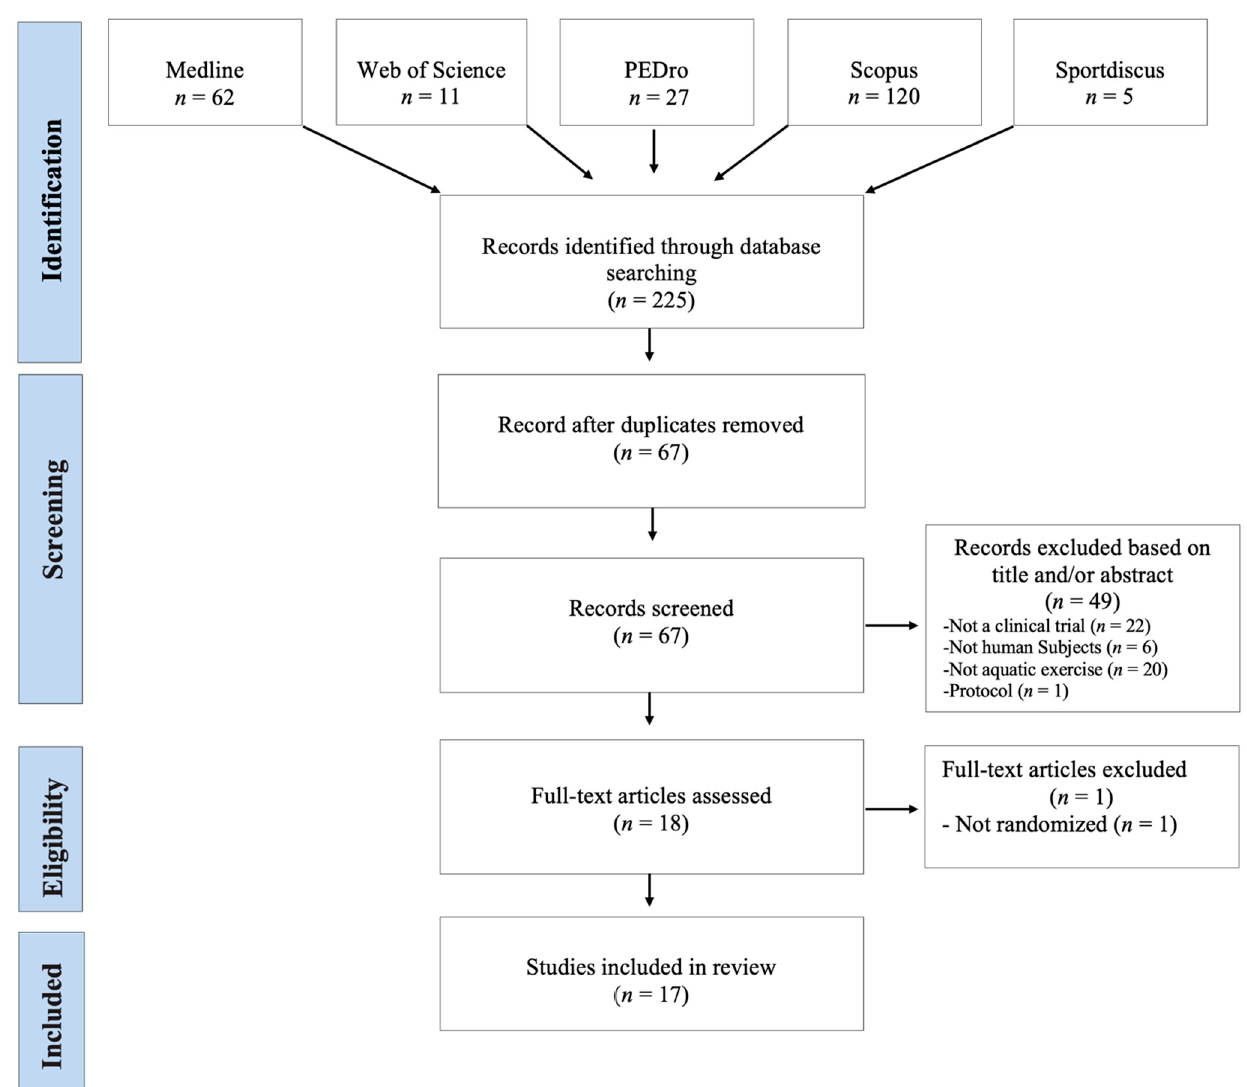
Figure 1. Flowchart of the included studies